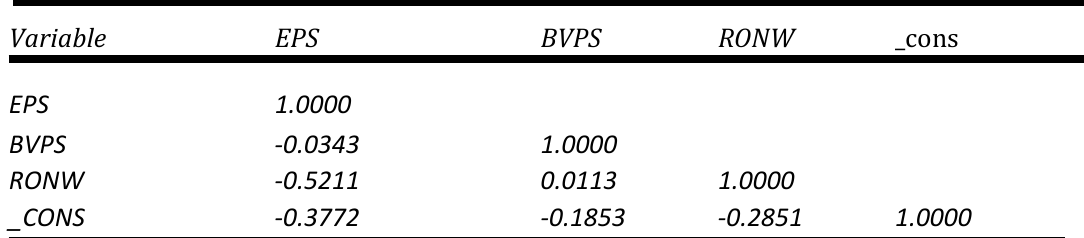
Table 3. Test of correlation between dependent and independent variables